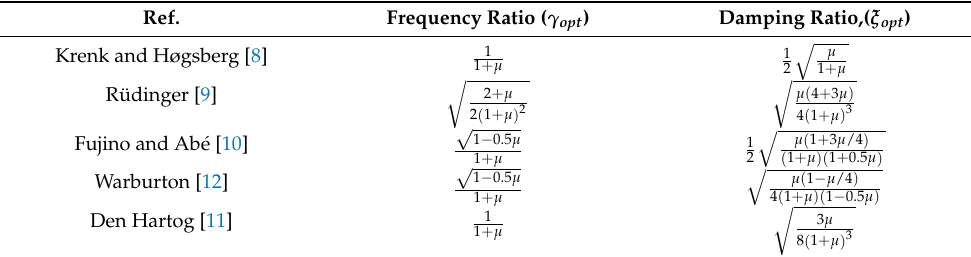
Table 3. Dynamic characteristics of the building frames. Ref.